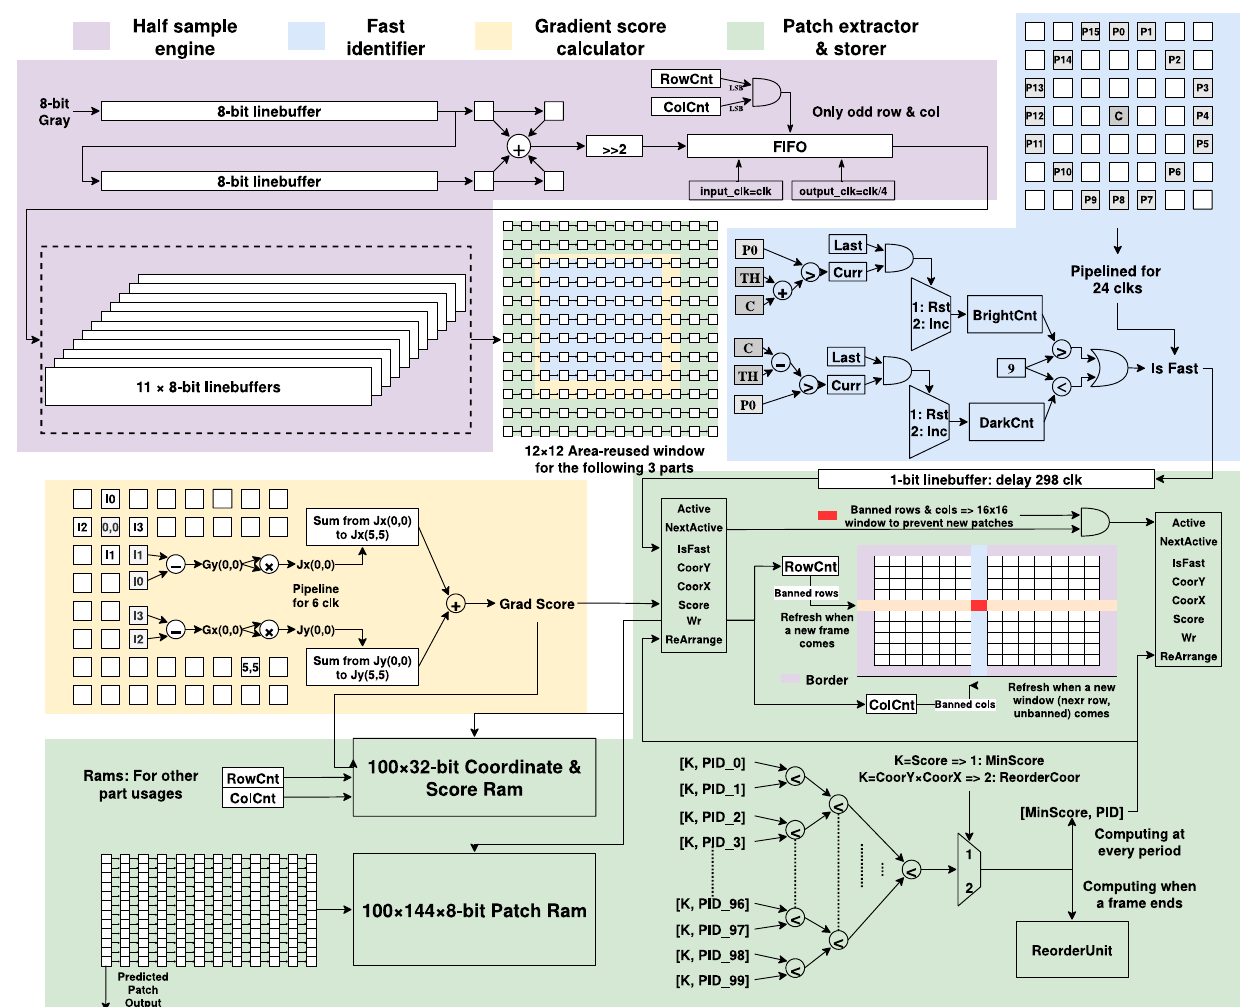
Figure 6 details the structure of the fixed-point vision pipeline, including a Gaussian pyramid-image half sample engine, a FAST feature identifier, a Grad score-based patch extractor, and a patch controller.